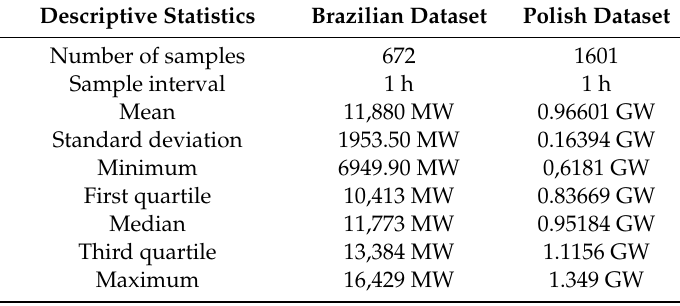
Table 2. Datasets description through